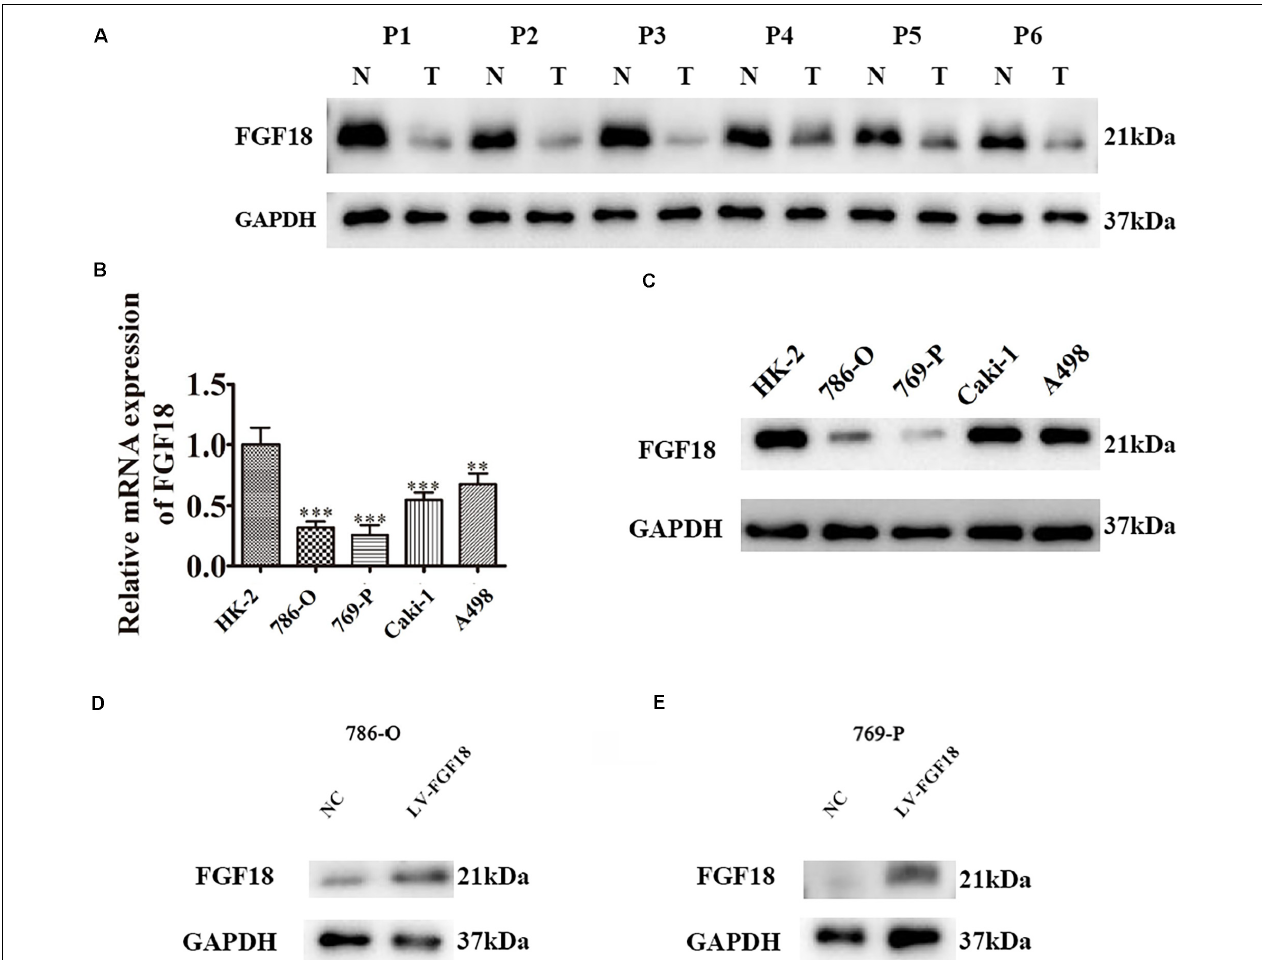
FIGURE 3 | Low expression of FGF18 in ccRCC clinical samples and cell lines. (A) The expression of FGF18 in six paired ccRCC normal and tumor tissues were analyzed with western blot. N, normal tissues; T, tumor tissues. (B) FGF18 expression in 786-O, 769-P, Caki-1, A498, and the normal renal epithelial cells HK-2 with RT-PCR. Data of three experiments are presented as the mean ± SD. ∗∗ P < 0.01, ∗∗∗ P < 0.001 versus the normal group. (C) FGF18 expression in 786-O, 769-P, Caki-1, A498, and the normal renal epithelial cells HK-2 with western blot. (D) Overexpression of FGF18 in 786-O using lentivirus. (E) Overexpression of FGF18 in 769-P using